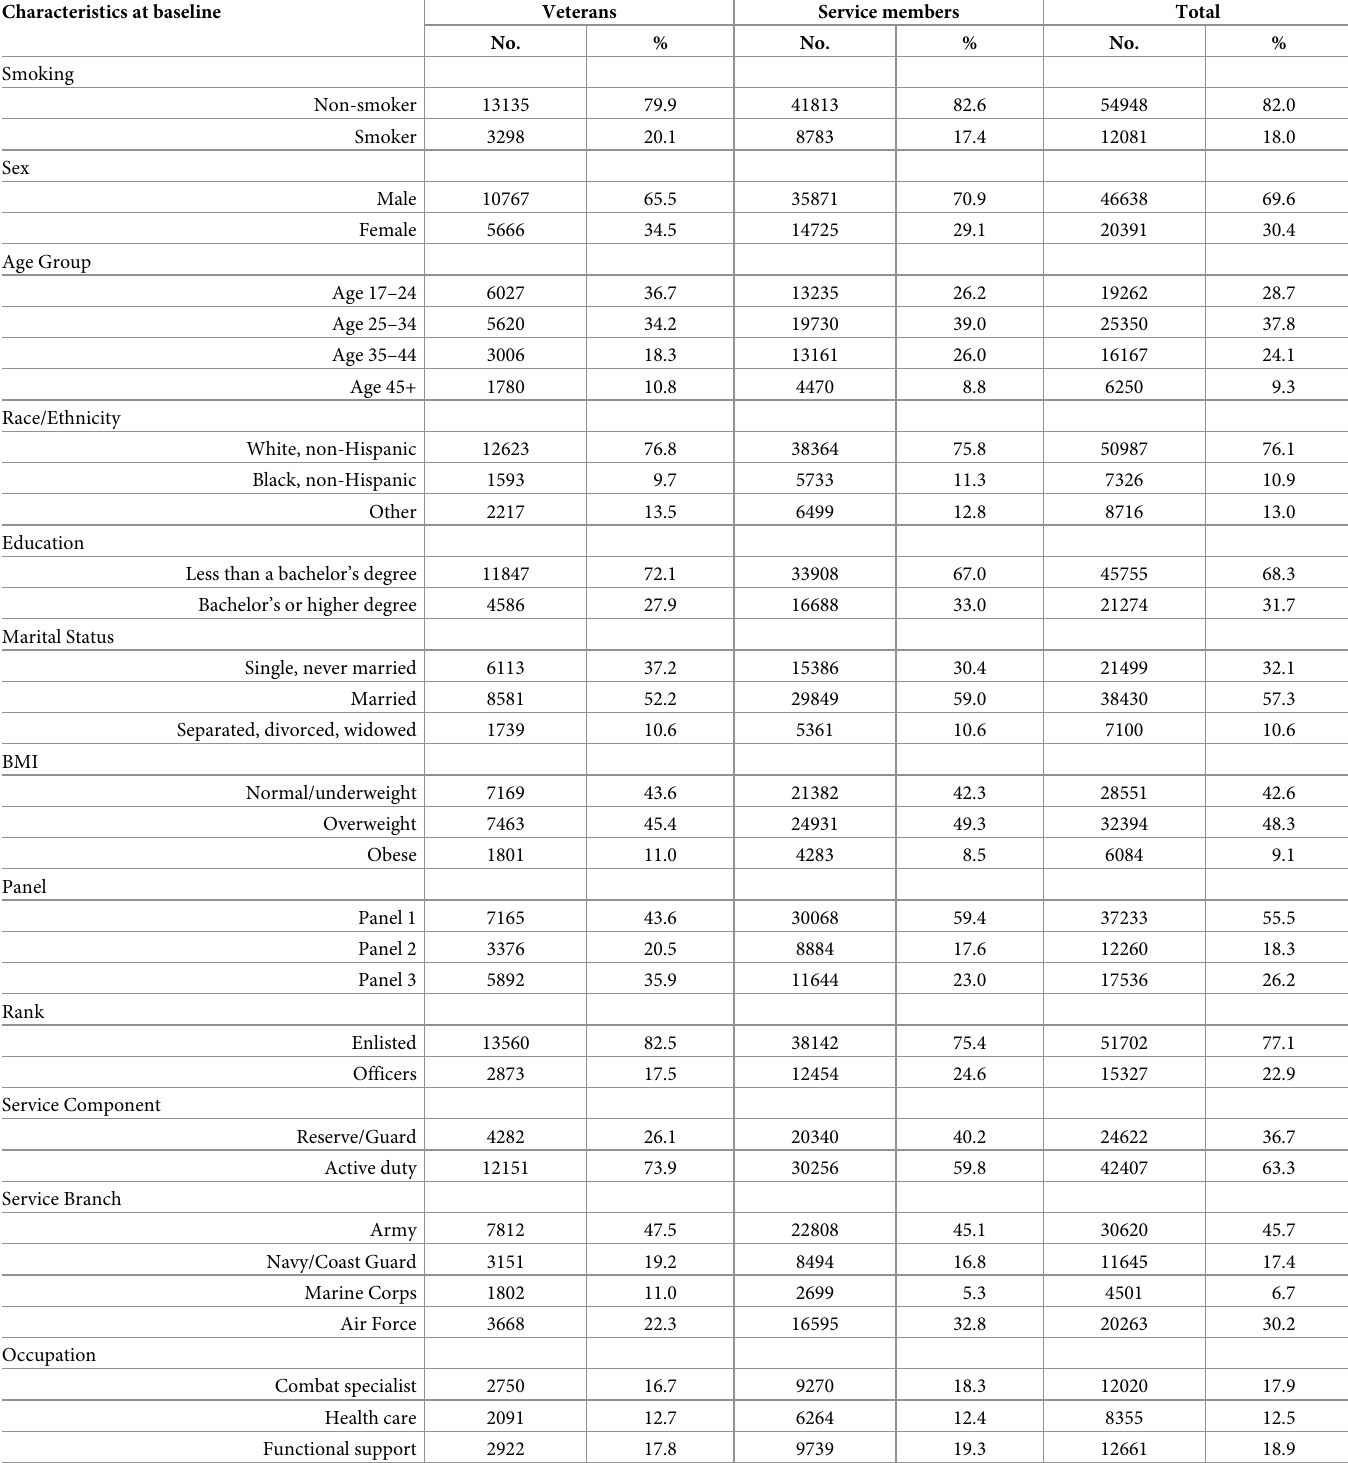
Table 1. Baseline demographic and military characteristics, health risk behaviors, and mental health conditions of study participants (N = 67,029), in the Millen- nium Cohort Study. Characteristics at